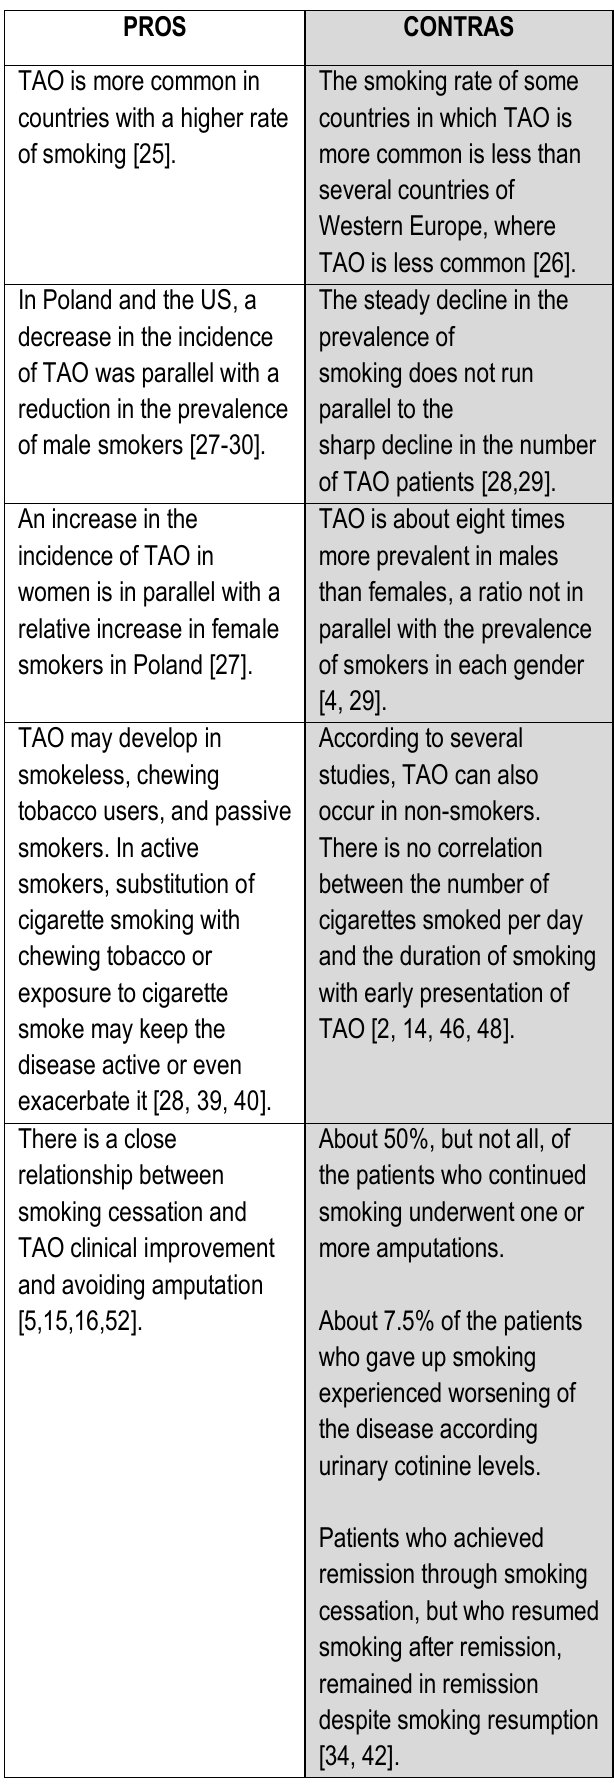
Table 1. Evidence on tobacco use and TAO PROS